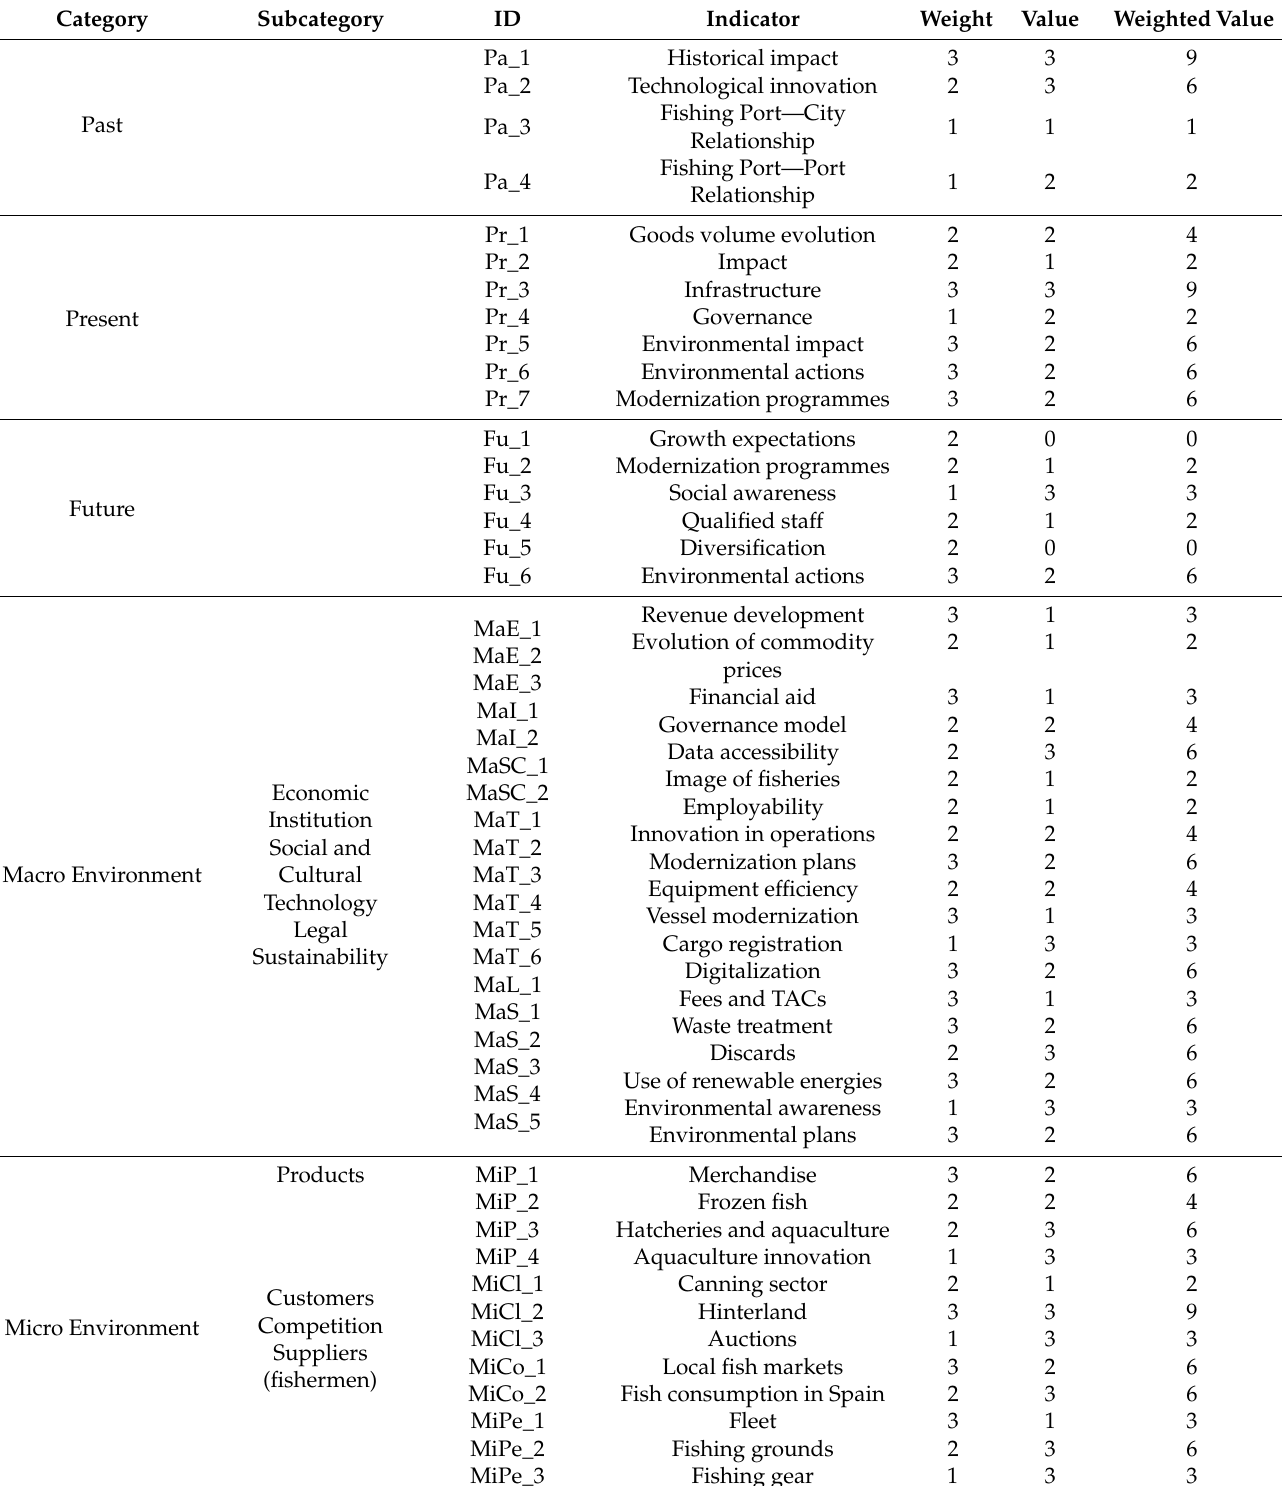
Table 1. IDIndicators database and measurement